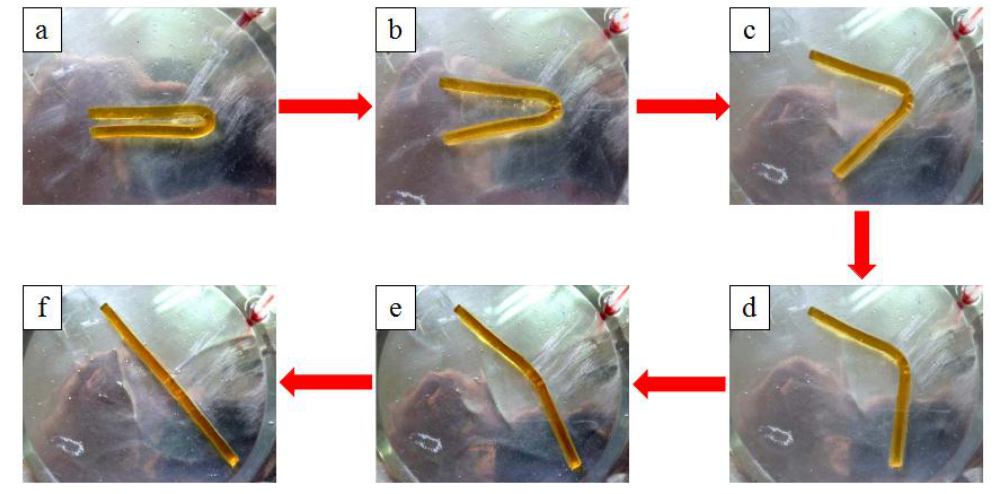
Figure 13. Process for the test of shape memory properties.